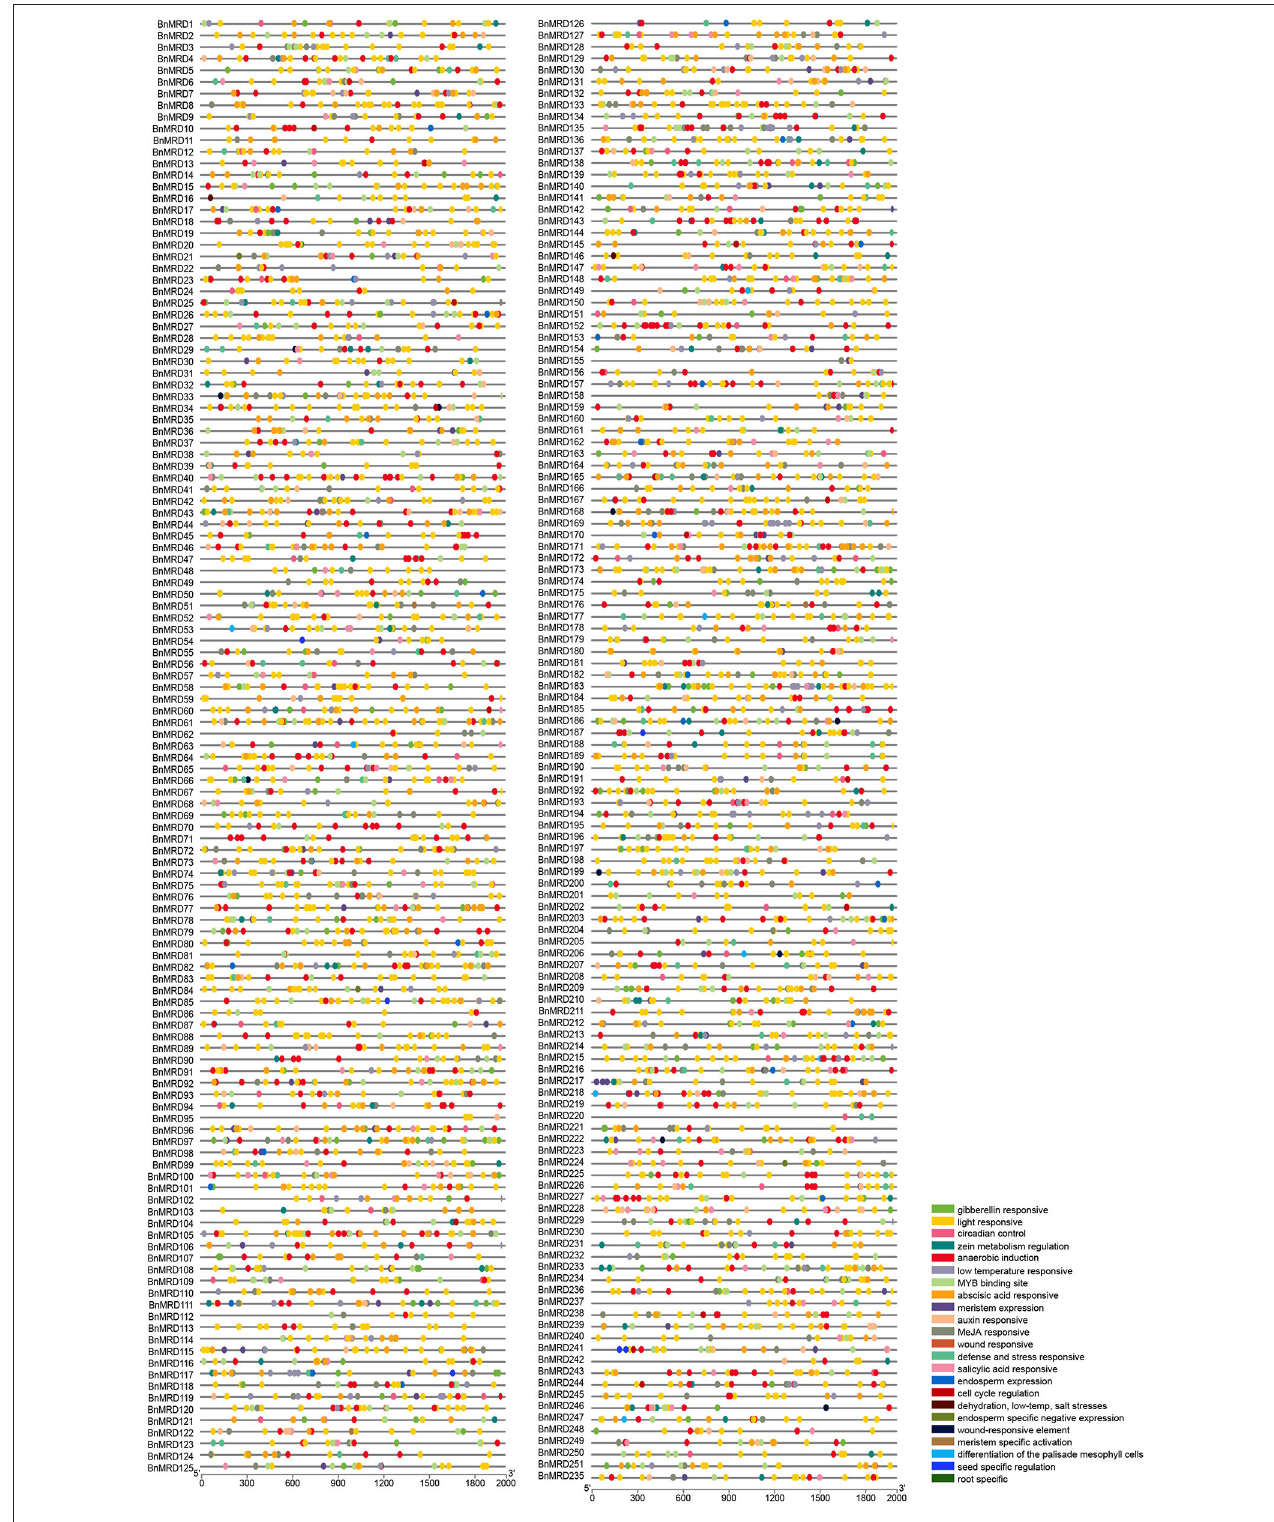
FIGURE 5 | Regulatory cis -elements on the promoter regions of BnMYB-related genes. Locations of different cis -acting elements are arranged on the lines representing the 2kb upstream region of TSS in the promoters of each BnMYB-related gene. Different colored ovals represent different types of cis -elements.